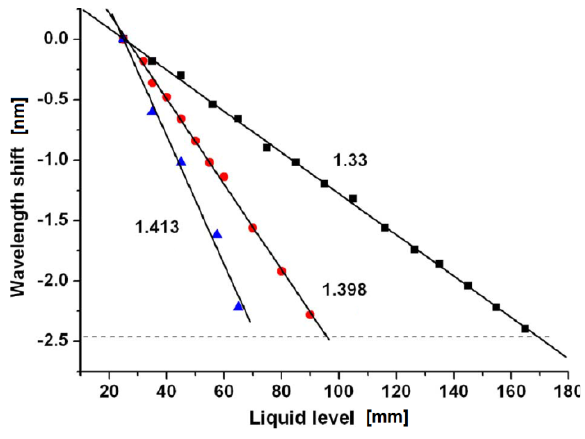
Figure 8. The relationship between peak wavelength and liquid-level with the surrounding liquid refractive indices